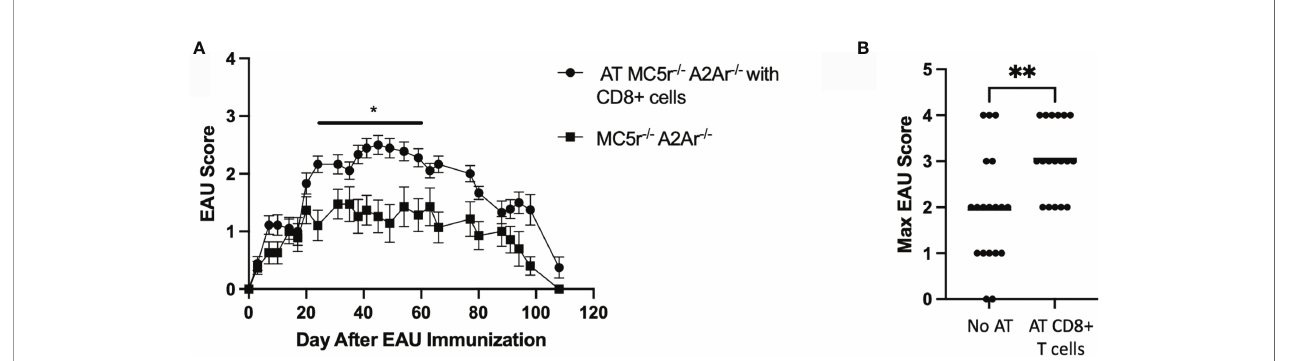
FIGURE 7 | The course of EAU in DKO mice following transfer of WT CD8 + T cells. EAU was induced in DKO mice that received an adoptive transfer of WT CD8 + T cells two days before immunization (solid line with circles, n = 18) or EAU DKO mice that did not receive a cell transfer (solid line with squares, n = 19). Mice were immunized for EAU and evaluated from the time of immunization every 3 - 4 days for clinical signs of uveitis (A) . The severity of disease is indicated by the maximum score of each mouse over the entire course of disease (B) . Each experiment consisted of 4-7 mice, and each experiment was repeated 3-4 times. Signi fi cance was assessed by two-way ANOVA with Bonferroni post-test for EAU scores over the course of disease and nonparametric Mann-Whitney U test for maximum scores. Statistical signi fi cance (*P ≤ 0.05 or **P ≤ 0.01) is designated by * and